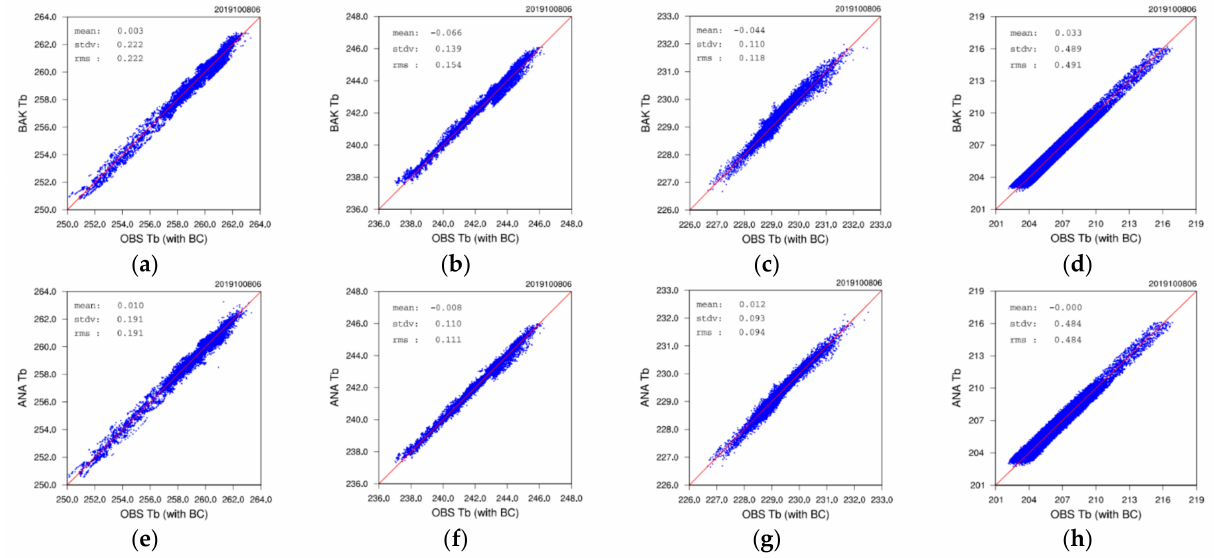
Figure 12. Scatter plots of model-calculated brightness temperature versus the observations (K) of GeoSTAR for ( a – d ) background and ( e – h ) analyses valid at 06:00 UTC on 8 October 2019. ( a , e ) rep- resents channel-4 53.596 GHz, ( b , f ) represents channel-5 54.4 GHz, ( c , g ) represents channel-6 54.94 GHz, and ( d , h ) represents channel-8 57.29